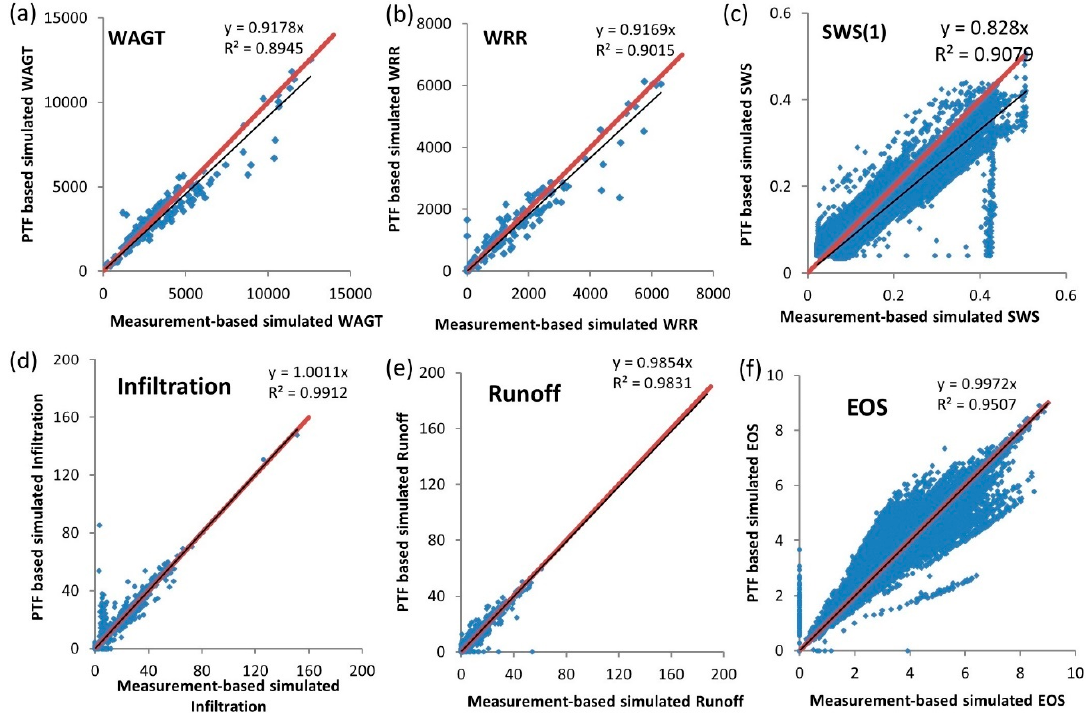
Figure 3. Relationship between use of measurement-based inputs and pedotrandfer functions derived (PTF-based) inputs on simulations of rice, ( a ) Total above-ground dry matter (WAGT) (kg/ha) of rice; ( b ) Dry weight of rough rice (WRR) (kg/ha); ( c ) Soil water content of the topsoil layer (SWS(1)) (mm/mm); ( d ) Daily infiltration (infiltration) (mm); ( e ) Daily runoff (runoff) (mm); and f) Potential evapotranspiration after modifications of green cover and residue (EOS) (mm).